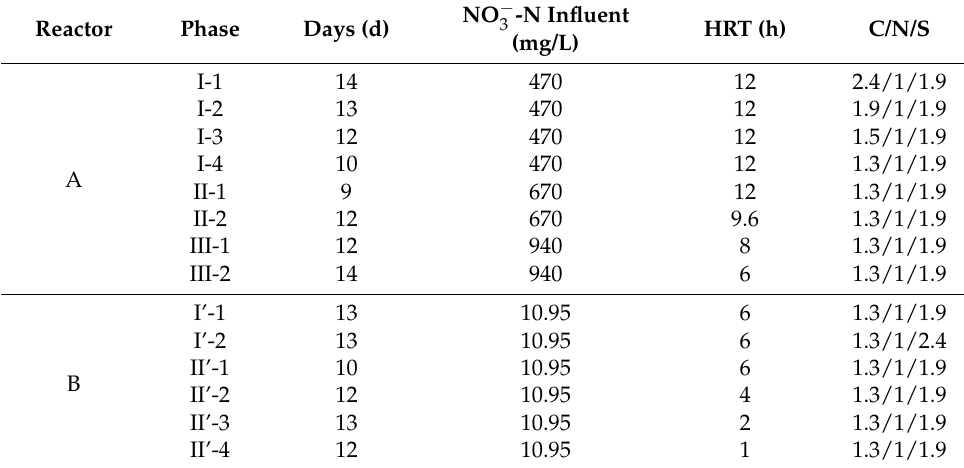
Table 2. Operating conditions of reactors used in this